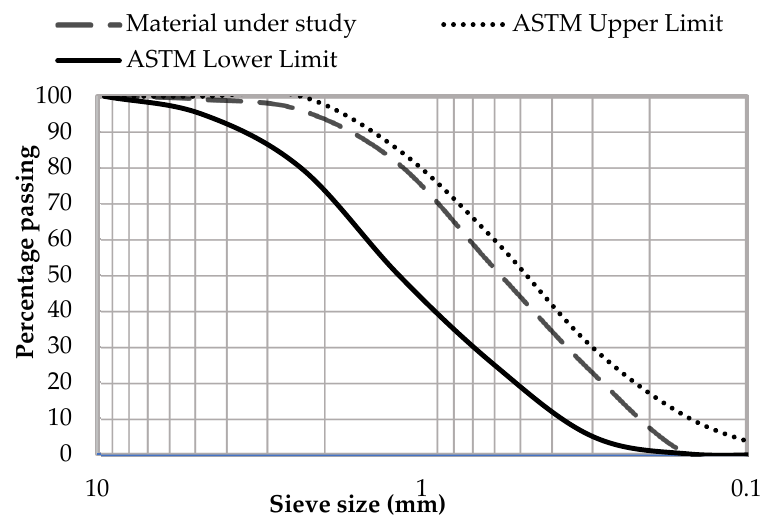
Figure 2. Gradation curve of coarse aggregate.